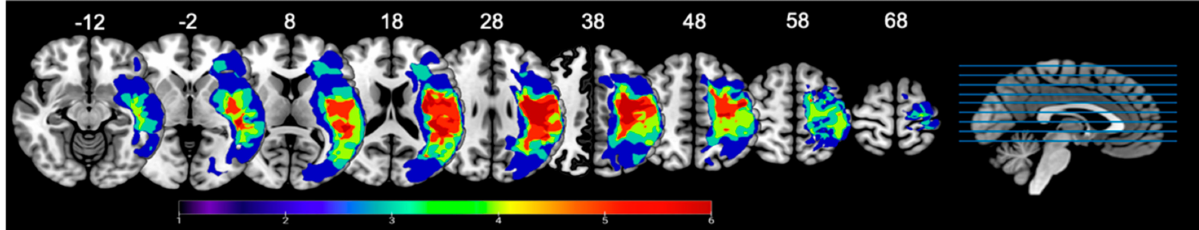
Figure 1. Lesion overlay maps illustrating lesion location and extent in our sample of 6 participants. Heat maps correspond to the number of patients that have a lesion in that area. Lesions are overlaid on labeled axial slices (z-coordinates) from the SPM152 template; SPM: Statistical Parametric Mapping. Images are presented in radiological view (i.e., left hemisphere is on the right